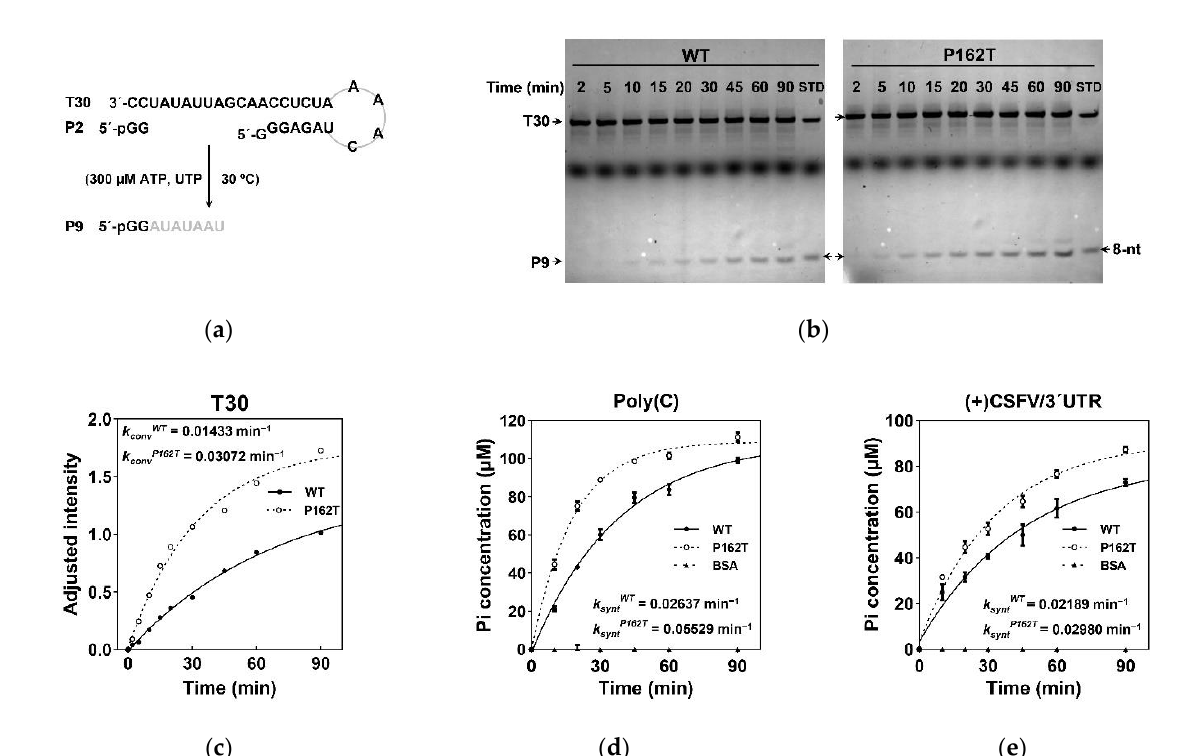
Figure 3. The NS5B RdRp activity in vitro. ( a ) Schematic diagram of the de novo RdRp assay in vitro. T30/P2 was used as the RNA substrate. The template strand T30 directed a 7-nt (grey) extension of the dinucleotide primer P2 (black) to produce a 9-nt product (P9) when ATP and UTP were supplied as the only NTP substrates. ( b ) Denaturing urea-PAGE analysis of the de novo RdRp assay. The P9 accumulation was monitored at the indicated time points for NS5B WT and NS5B P162T constructs. The oval-shaped band between T30 and P9 is the Xylene Cyanol FF. An 8-nt marker was used as the standard sample for quantitation (set to 1). The 8-nt marker bearing hydroxyl groups at the 5′ -end was chemically synthesized and therefore migrated slower than the P9 bearing a 5′ -phosphate. STD, standard sample containing T30 and 8-nt marker. ( c ) Comparison of de novo RdRp activity for NS5B WT and NS5B P162T . The relative intensity of P9 product was plotted as a function of time to estimate the apparent P9 conversion rate constant ( k conv ) by fitting to a one phase exponential association model. ( d , e ) Comparison of RdRp activity for NS5B WT and NS5B P162T by colorimetric assay using the poly(C) and (+) CSFV/ 3′ UTR templates. The Pi concentration was plotted as a function of time to fit to a one phase exponential association model and the apparent synthetic rate constant ( k synt ) was estimated.